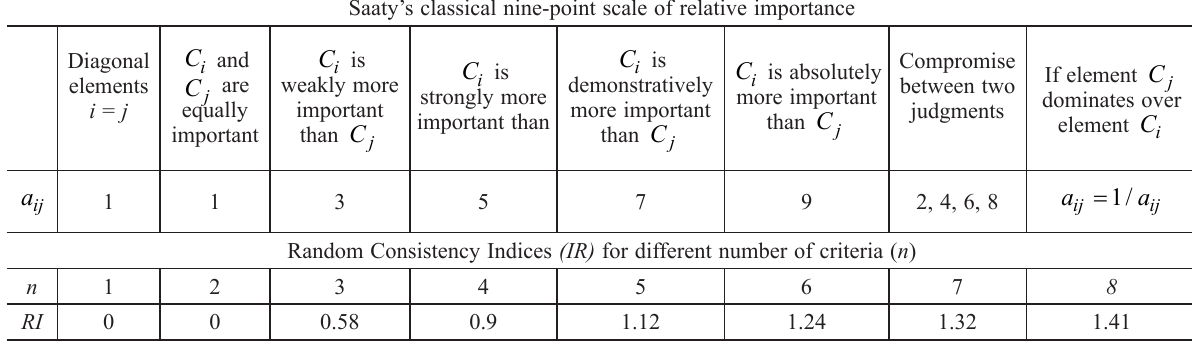
Table 2. Initial data for pairwise